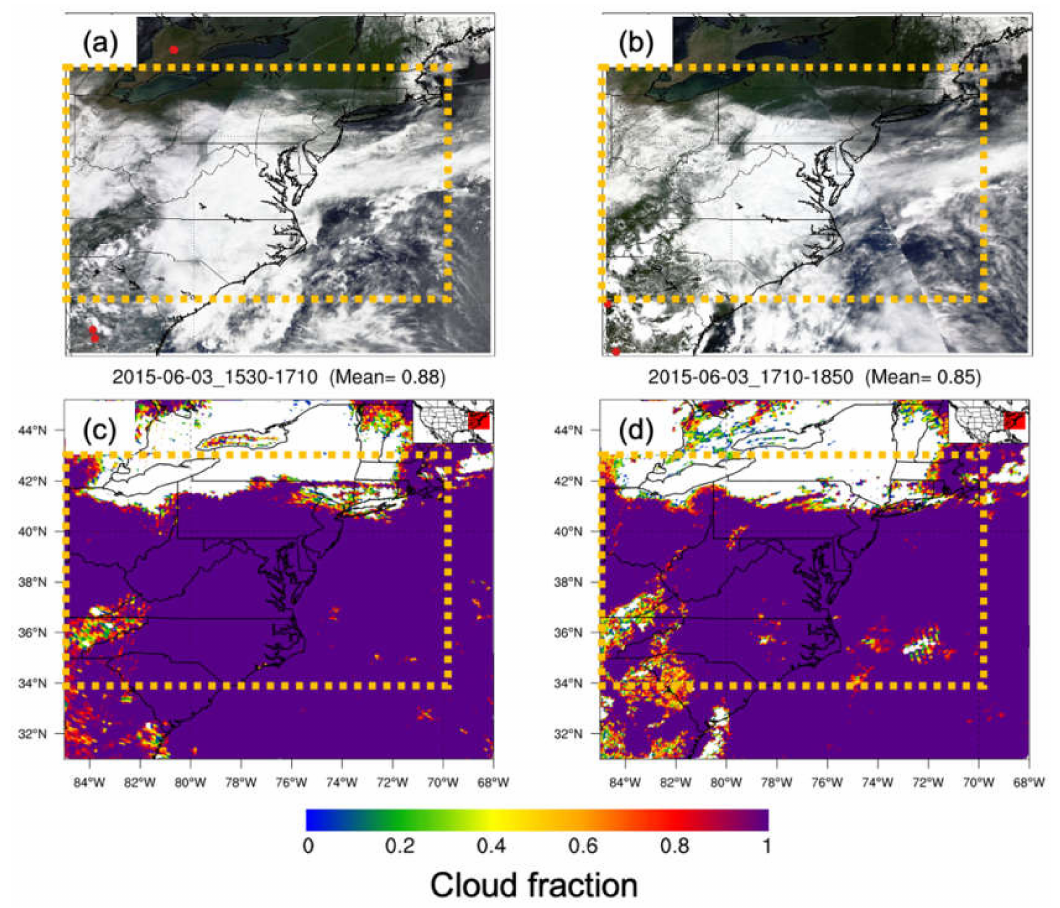
Figure 3. MODIS three-band color overlay images (band 1—red, band 4—green, and band 3—blue) from Terra ( a ) and Aqua ( b ) satellites on 3 June 2015. Red dots indicate the locations of daytime fires detected by MODIS. Note that the fire dot scale has been enlarged to portray the fires more clearly in the figure. Bottom images show MODIS cloud fractions from Terra ( c ) and Aqua ( d ). The orange dashed rectangle is the outer domain (d01).